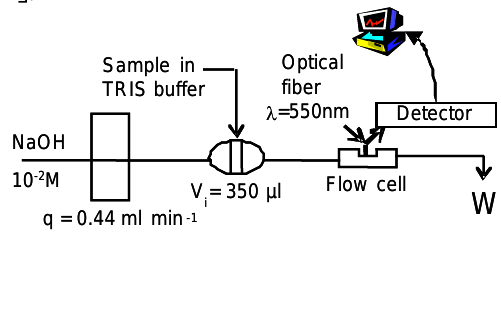
Figure 4. Flow-injection